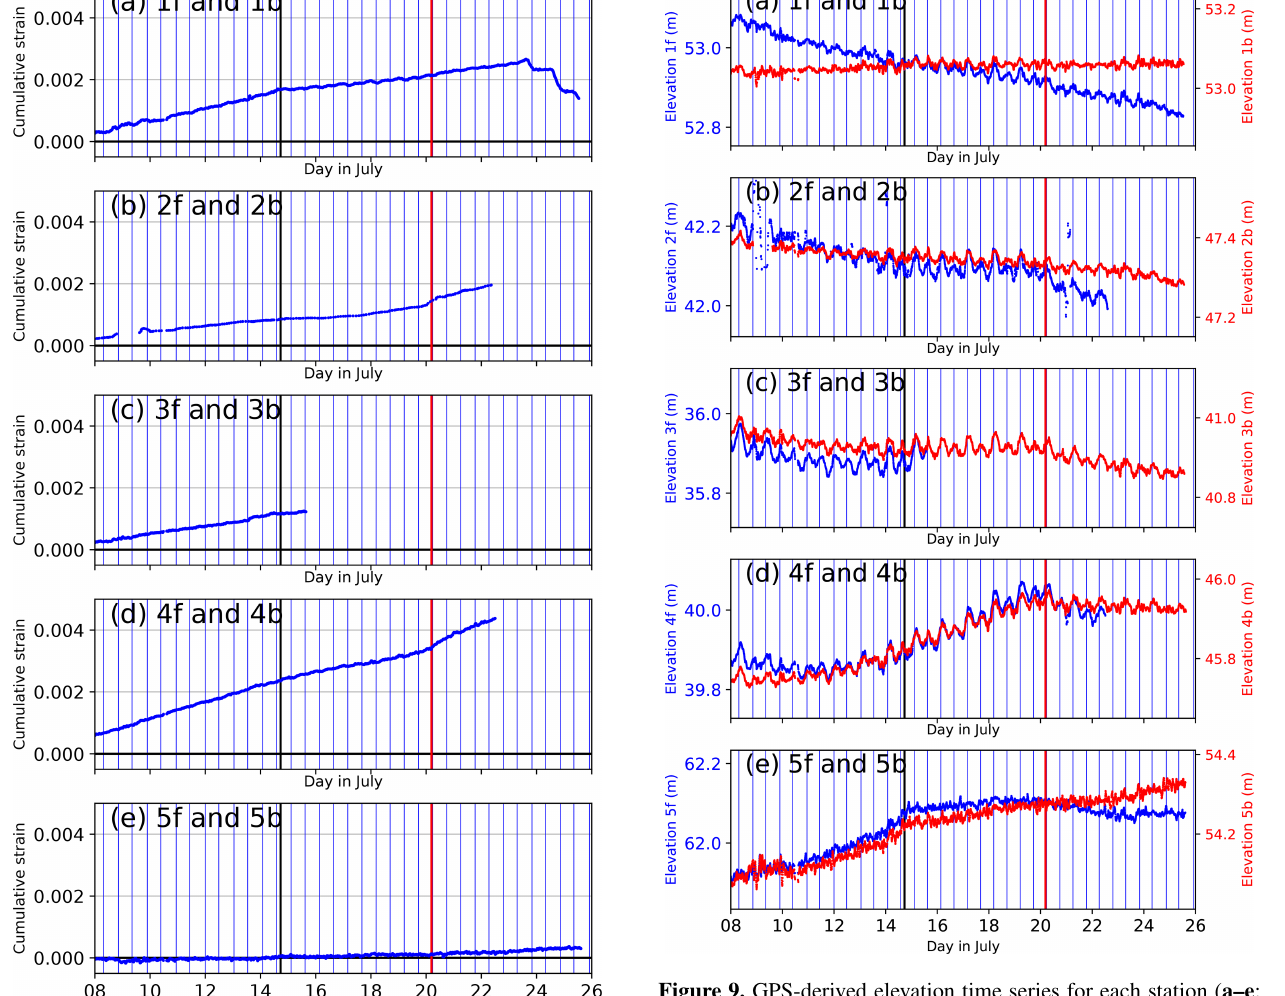
Figure 9. GPS-derived elevation time series for each station ( a–e ; applying a 1h moving average), timing of high tide (vertical blue lines), the speed-up (black lines), and the 20 July 2019 calving event (red lines). Stations closest to the calving front are shown in blue (1f–5f), stations ≈ 120m further away in red (1b–5b; see Fig. 3c for positions of GPS